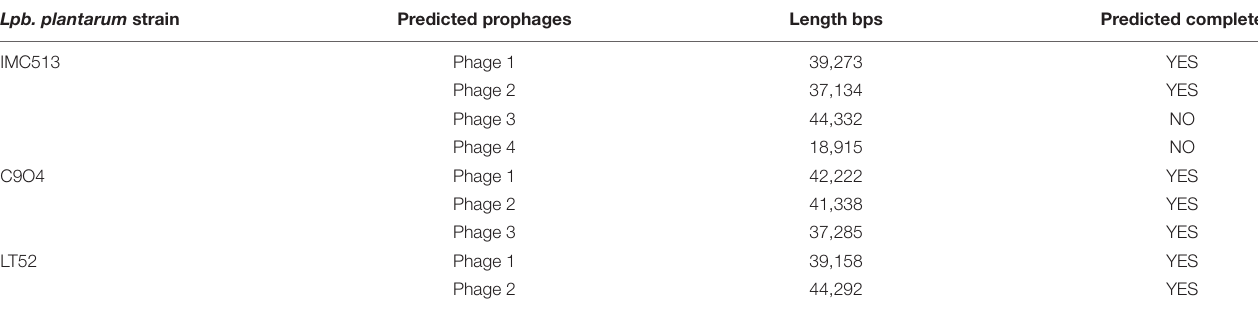
TABLE 5 | PHASTER analysis of the three Lpb. plantarum